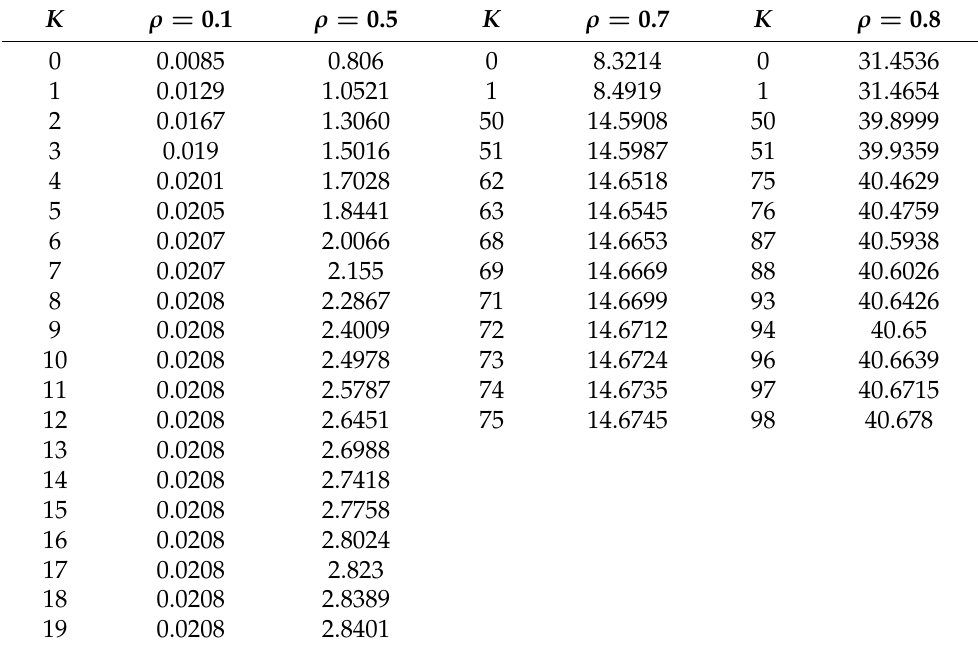
Table 2. The values of L for different values of ρ and K